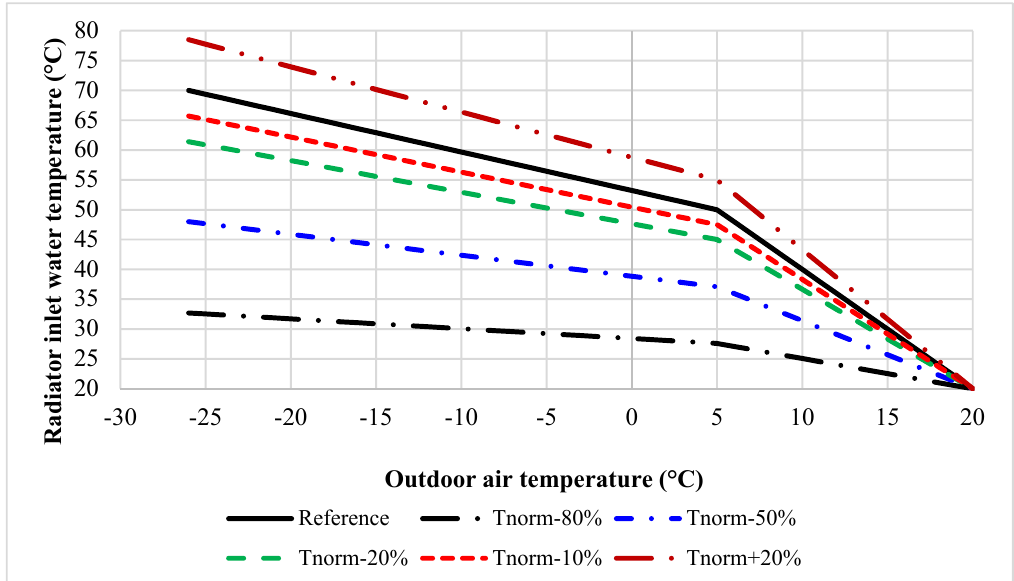
Figure 6. Radiator inlet water temperature control curves in the reference case and in the cases with relative heating power decreases.